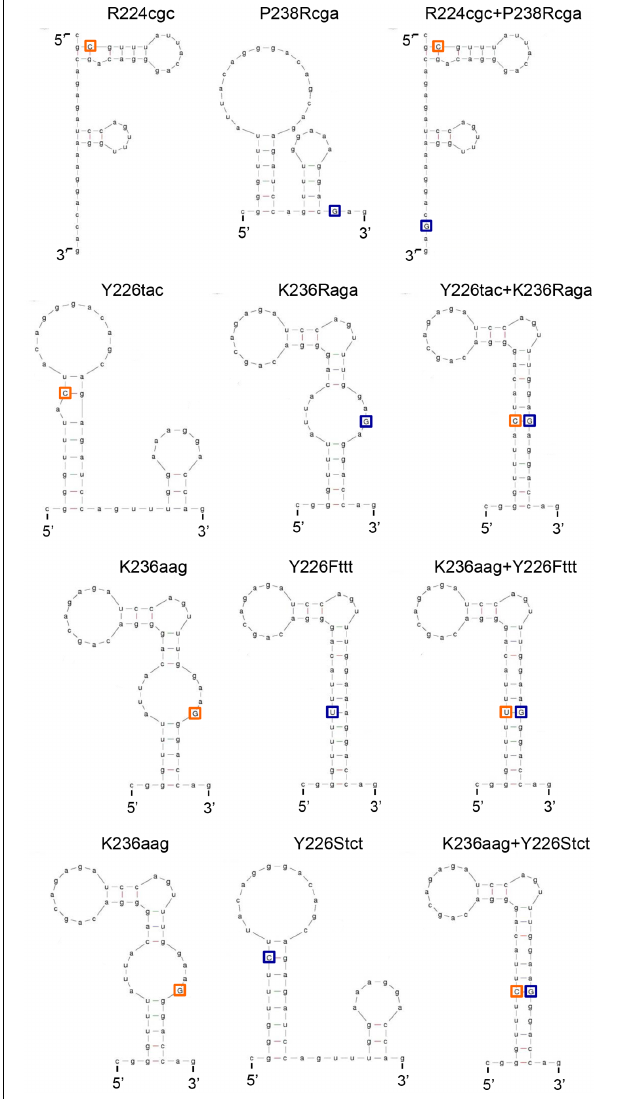
mutants. Secondary RNA structures of the SLSA1 mutants were predicted by mfold program (Zuker, 2003). In the structures of SLSA1 variants, their nSNVs analyzed are indicated by orange-boxed capital letters. Complementary mutations to the nSNVs are indicated by blue-boxed capital